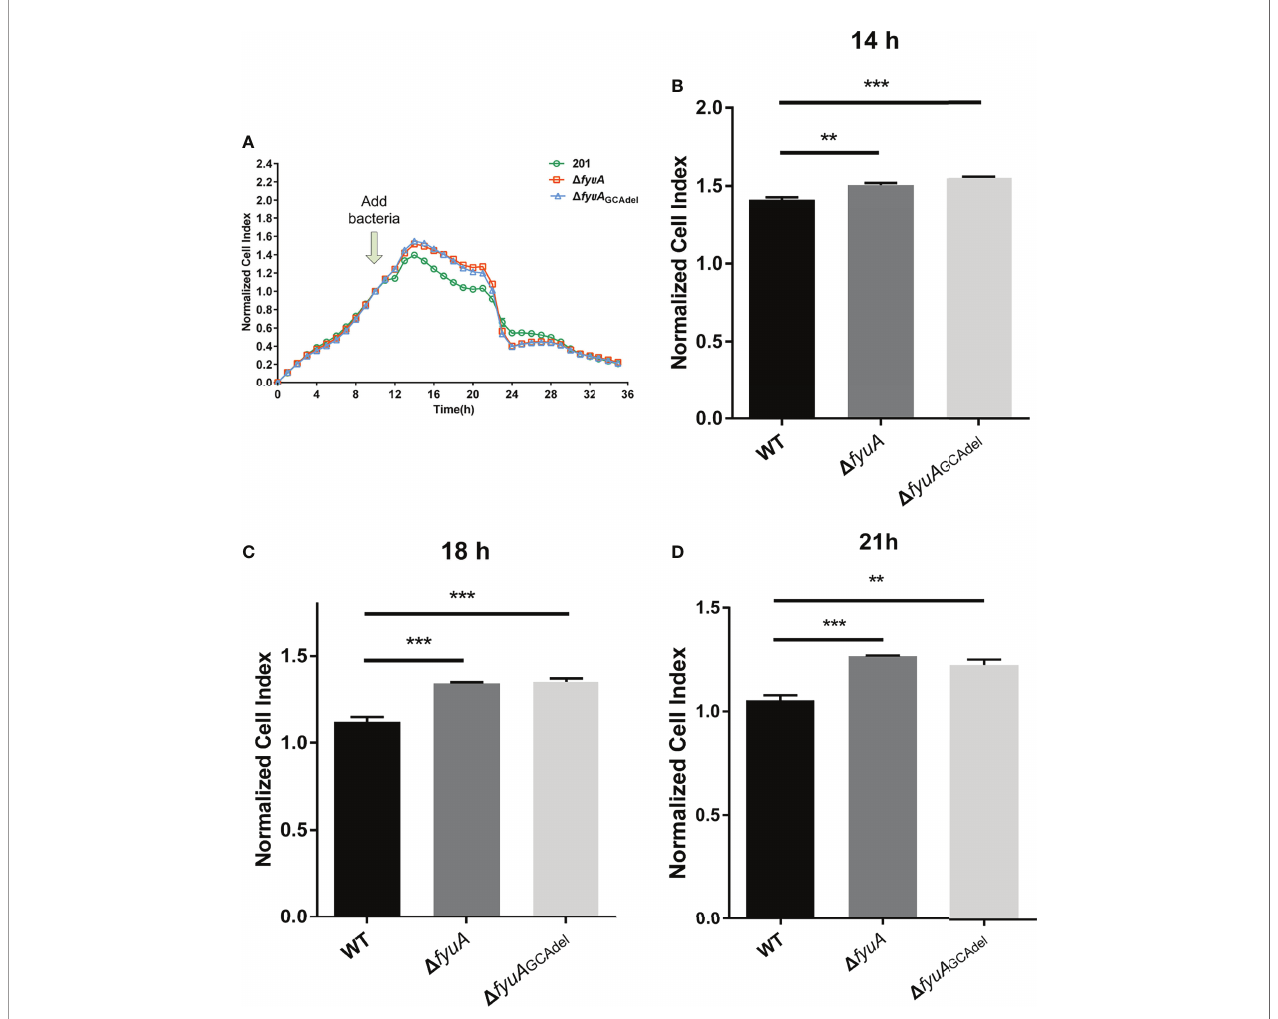
FIGURE 2 | Real-time cell analysis assay curves of HeLa cells infected with WT and the two mutants. (A) Normalized CI value curves. The bacteria were added to the cell culture at 10h. (B) Normalized CI values of 14h (4h post infection). (C) Normalized CI values of 18h (8h post infection). (D) Normalized CI values of 21h (11h post infection). **, p < 0.01. ***, p <